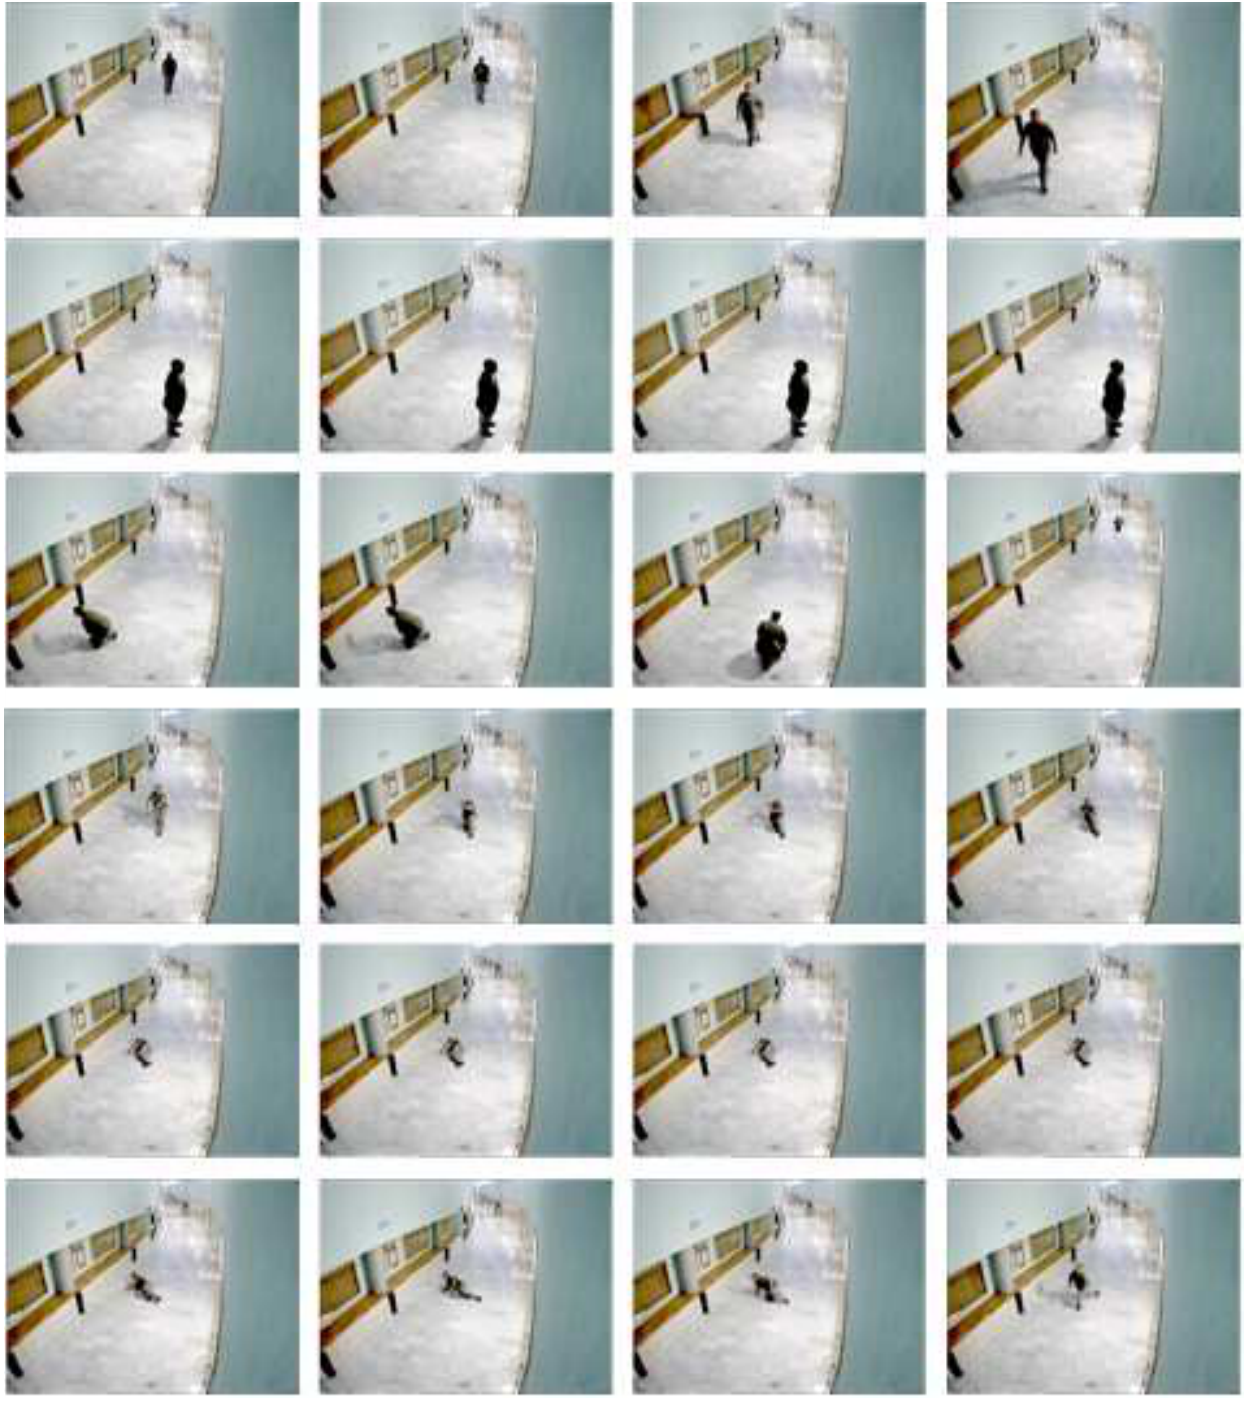
Figure 4. Examples of the activities to recognize. First row, walking . Second row, stopped . Third row, lowing . Fourth row, falling . Fifth row, lied down . Last row,